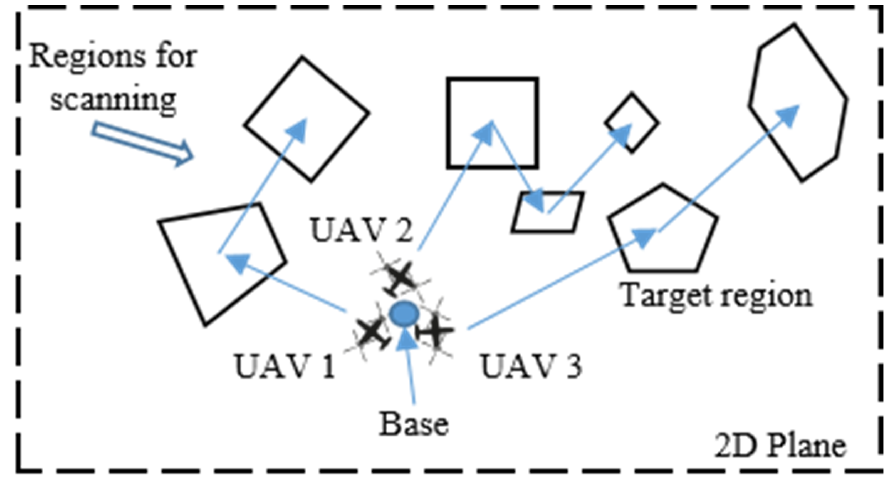
Figure 2. The problem description of multi-regional CPP for multiple UAVs.